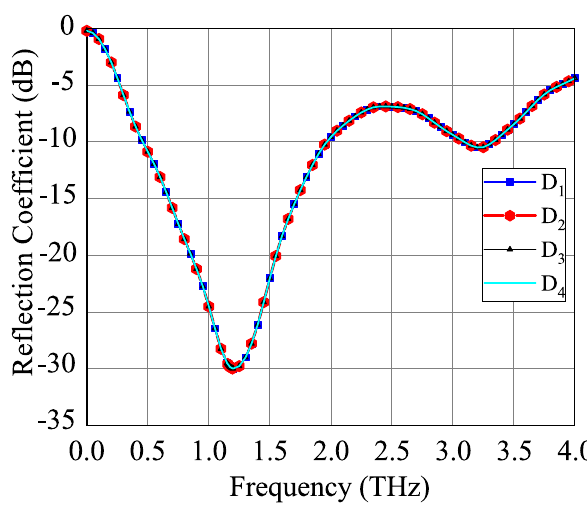
Figure 2. S 11 parameter of the proposed graphene THz antenna for four working